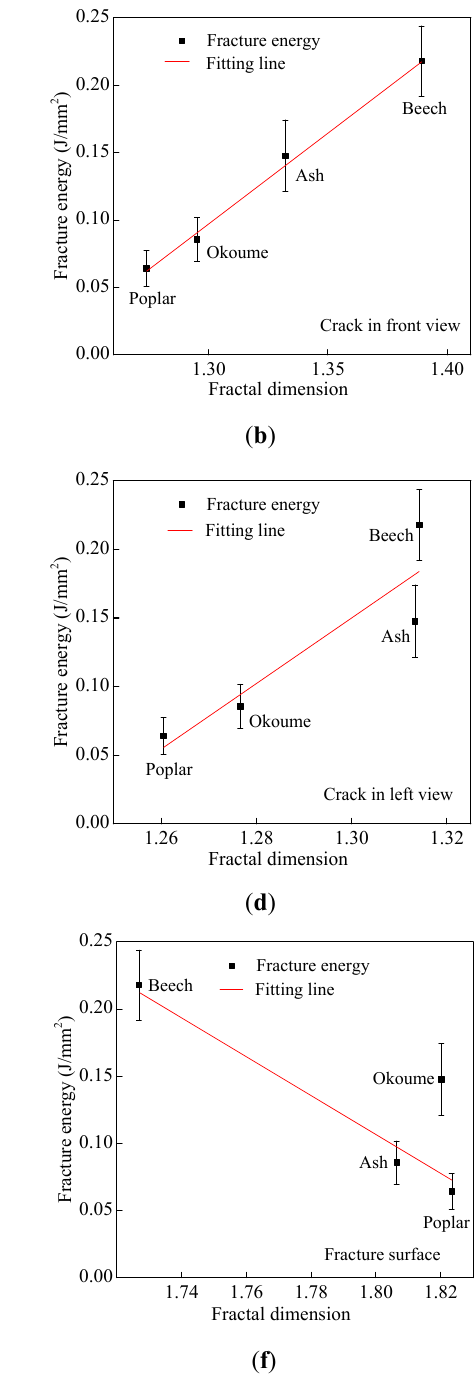
Figure 8. Relationships between critical stress intensity factor and fracture energy vs. fractal dimension: ( a ) critical stress intensity factor vs. fractal dimension of crack in front view, ( b ) critical stress intensity factor vs. fractal dimension of crack in front view, ( c ) critical stress intensity factor vs. fractal dimension of crack in left view, and ( d ) fracture energy vs. fractal dimension of crack in left view, ( e ) critical stress intensity factor vs. fractal dimension of fracture surface, and ( f ) fracture energy vs. fractal dimension of fracture surface.